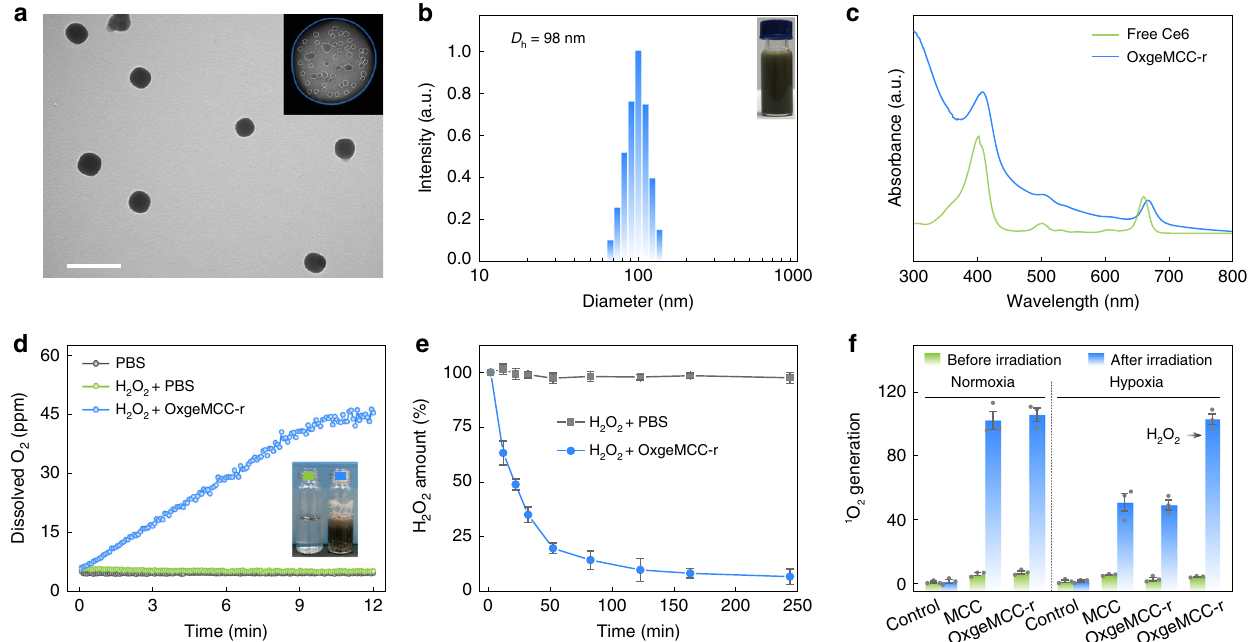
Fig. 4 Structure, oxygen generation, and singlet oxygen generation of OxgeMCC-r SAE. a Representative TEM image. Inset is the enlarged image of one single OxgeMCC-r SAE after reversed-phase treatment. White dotted circles indicate the encapsulated Ce6. Scale bar is 200 nm. b DLS pro fi le with the inset picture of the sample dispersed in water. c UV-vis absorption spectra of free Ce6 and OxgeMCC-r SAE. d O 2 generation after treating OxgeMCC-r SAE with H 2 O 2 in PBS. Inset is a photograph of H 2 O 2 solutions in the presence or absence of OxgeMCC-r SAE. e Degradation pro fi les of H 2 O 2 with or without of OxgeMCC-r SAE. f Singlet oxygen ( 1 O 2 ) generation ability determined by DPBF indicator under different conditions before and after laser irradiation (671 nm, 100 mW cm − 2 , 30 s). Data are presented as mean ± s.e.m. ( n =